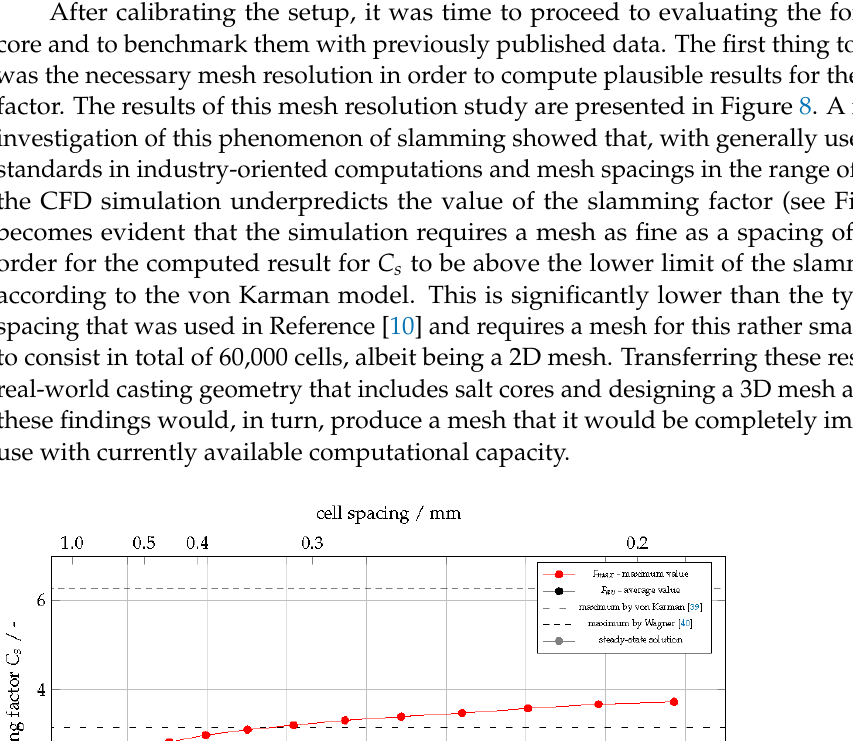
Figure 7. The velocity magnitude field at the times of impact and immediately afterwards: ( a ) t · U 0.2; ( b ) t · U = 0.205; ( c ) t · U = 0.21. Here, U = U in with U in = 20 ms − 1 . R R